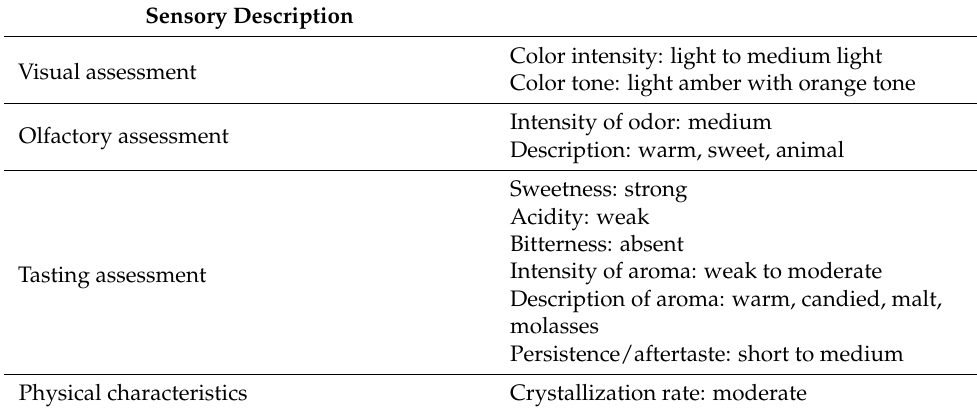
Table 4. Sensory profile of Himalayan balsam honey (n =